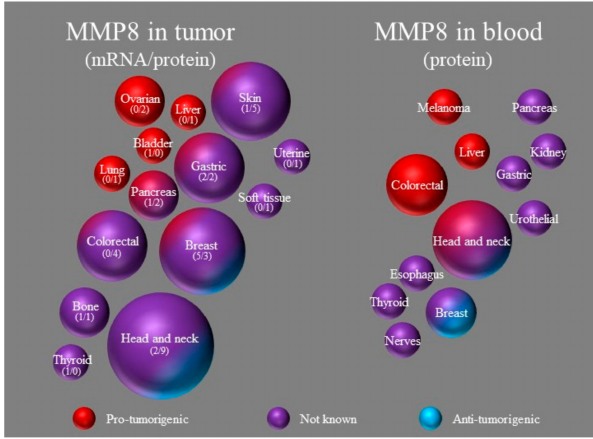
Figure 1. The e ff ect of MMP8 in tumor or blood on cancer prognosis. The size of the ball is in portion to the number of publications on that cancer, the number in brackets depicts studies on mRNA or protein. The color of the ball depicts the e ff ects of MMP8 on that